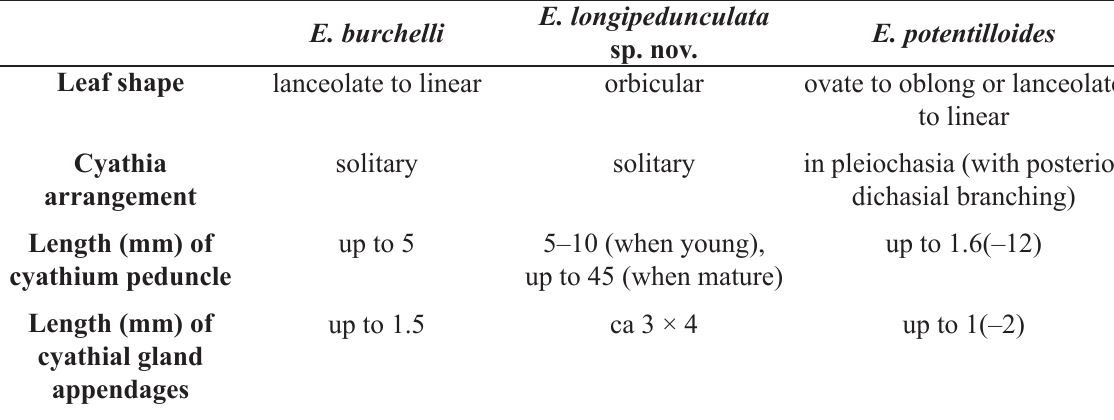
Table 2. Morphological comparison among Euphorbia burchelli Müll.Arg., E. longipedunculata